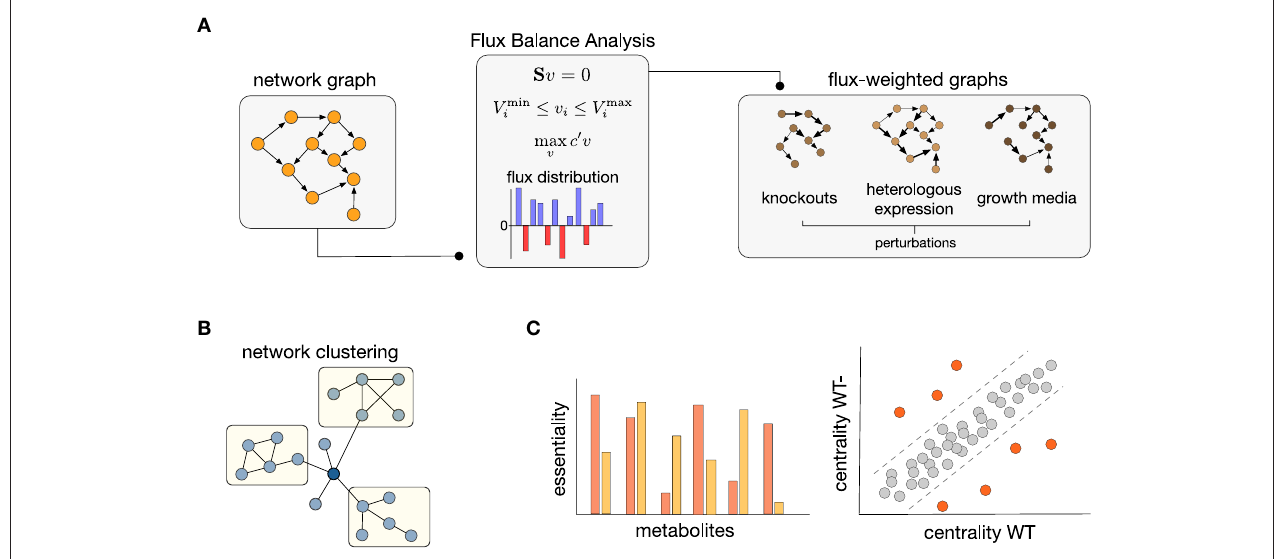
FIGURE 2 | Integration of Flux Balance Analysis and graph theory. (A) Construction of flux-weighted graphs. Starting from a network graph, FBA solutions can be used to weight the graph edges, leading to different instances of the same graph for various perturbations such as gene knockouts, heterologous gene expression, or changes in growth conditions. (B) Clustering of flux-weighted graphs can reveal hidden groupings in the structure of metabolic networks ( Yoon et al., 2007; Beguerisse-Díaz et al., 2018 ). (C) Essentiality and node centrality are two areas where flux-weighted graphs offer promising potential. (Left) New essentiality scores can be defined to rank metabolites according to their impact on the phenotype (Koschützki et al., 2010; Riemer et al., 2013; Laniau et al., 2017). (Right) Changes in node centrality between wild type (WT) and deletion (WT-) networks can reveal the molecular players associated to disease phenotypes; orange nodes denote reactions that undergo substantial changes in centrality upon gene deletions ( Li et al., 2013; Beguerisse-Díaz et al.,